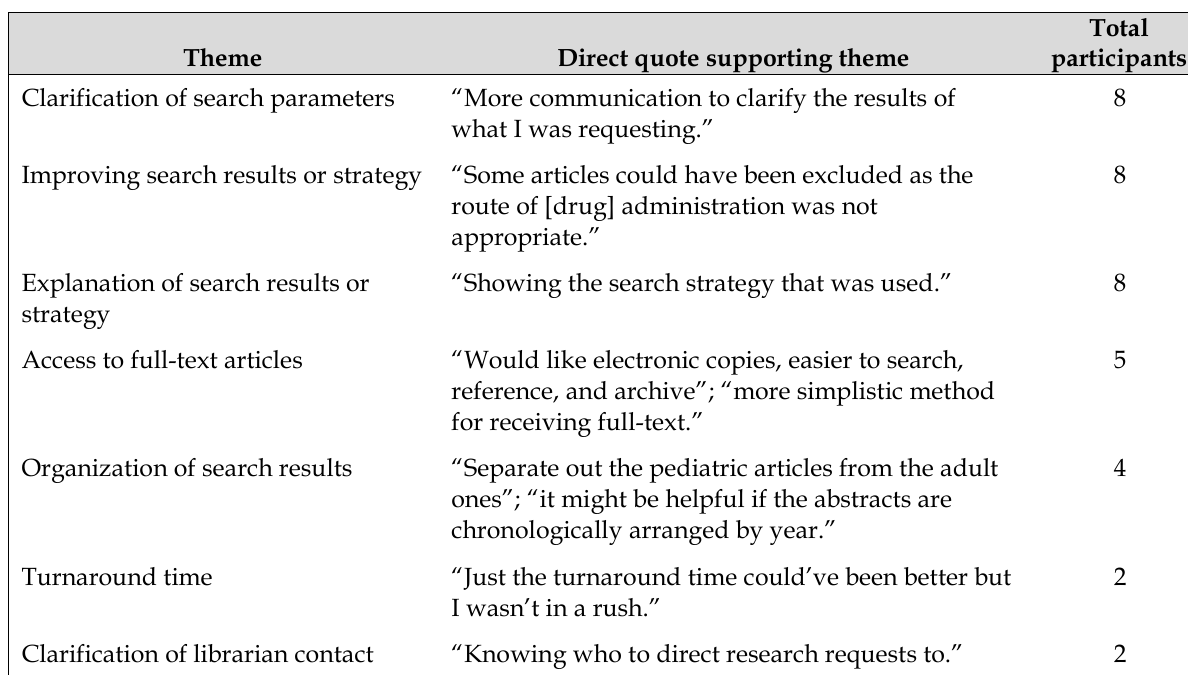
Table 1 Suggestions for improving the search results and